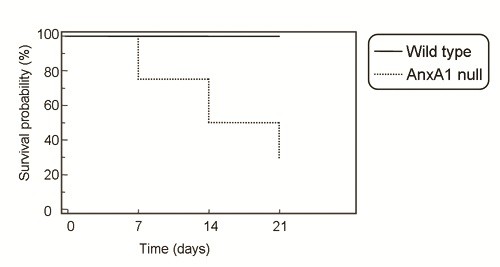
Bleomycin lethality in AnxA1 null mice. Wild type and AnxA1 null mice received 0.15 U/Kg bleomycin i.t. at time 0 and survival rate was monitored daily up to 21 days. Results are cumulated from three experiments with a total of 15 mice per group.